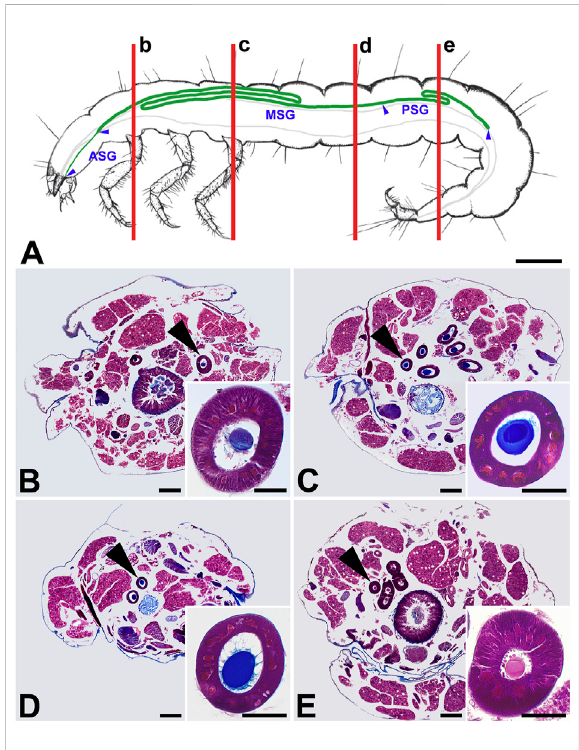
FIGURE 2 Morphologyofthesilkgland(SG)from P.conspersa lastinstar larvae. (A) Schematic illustration of the SG anatomy in the larval body; blue arrowheads show the boundaries of the SG compartments, i.e., where anterior, middle, and posterior SG (ASG,MSG,and PSG)part. Vertical redlinesmarked bysmall letters (b – e) refer to the whole-body sections (B – E) and show the approximate position where the glands were cut in the respective transverse paraplast sections; (B – E) Transverse paraplast sections through the body of a fi fth instar larva stained with Masson trichrome stain. Inserted images show higher magni fi cation of the SG section pointed by the arrowheads; (B – D) MSG front, middle and rear portions; (E) PSG. Scale-bars: (A) 1,000 μ m; (B – E) , 200 μ m; inset images, 50 μ